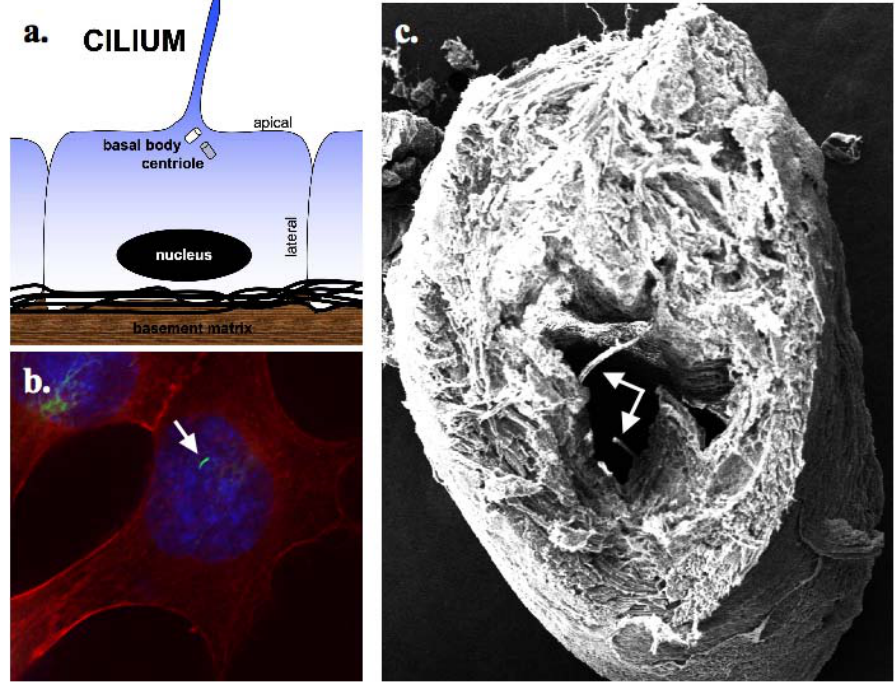
Figure 1. Cilia are sensory organelles that project from the apical sides of cells. (a) A cartoon depicts extension of cilia from one of the centrioles, which is termed basal body. (b) Immunostaing study shows the presence of a cilium of an endothelial cell. (c) Electron micrograph further confirms the presence of cilia in the lumen of embryonic aorta in vivo . Arrows indicate the presence of